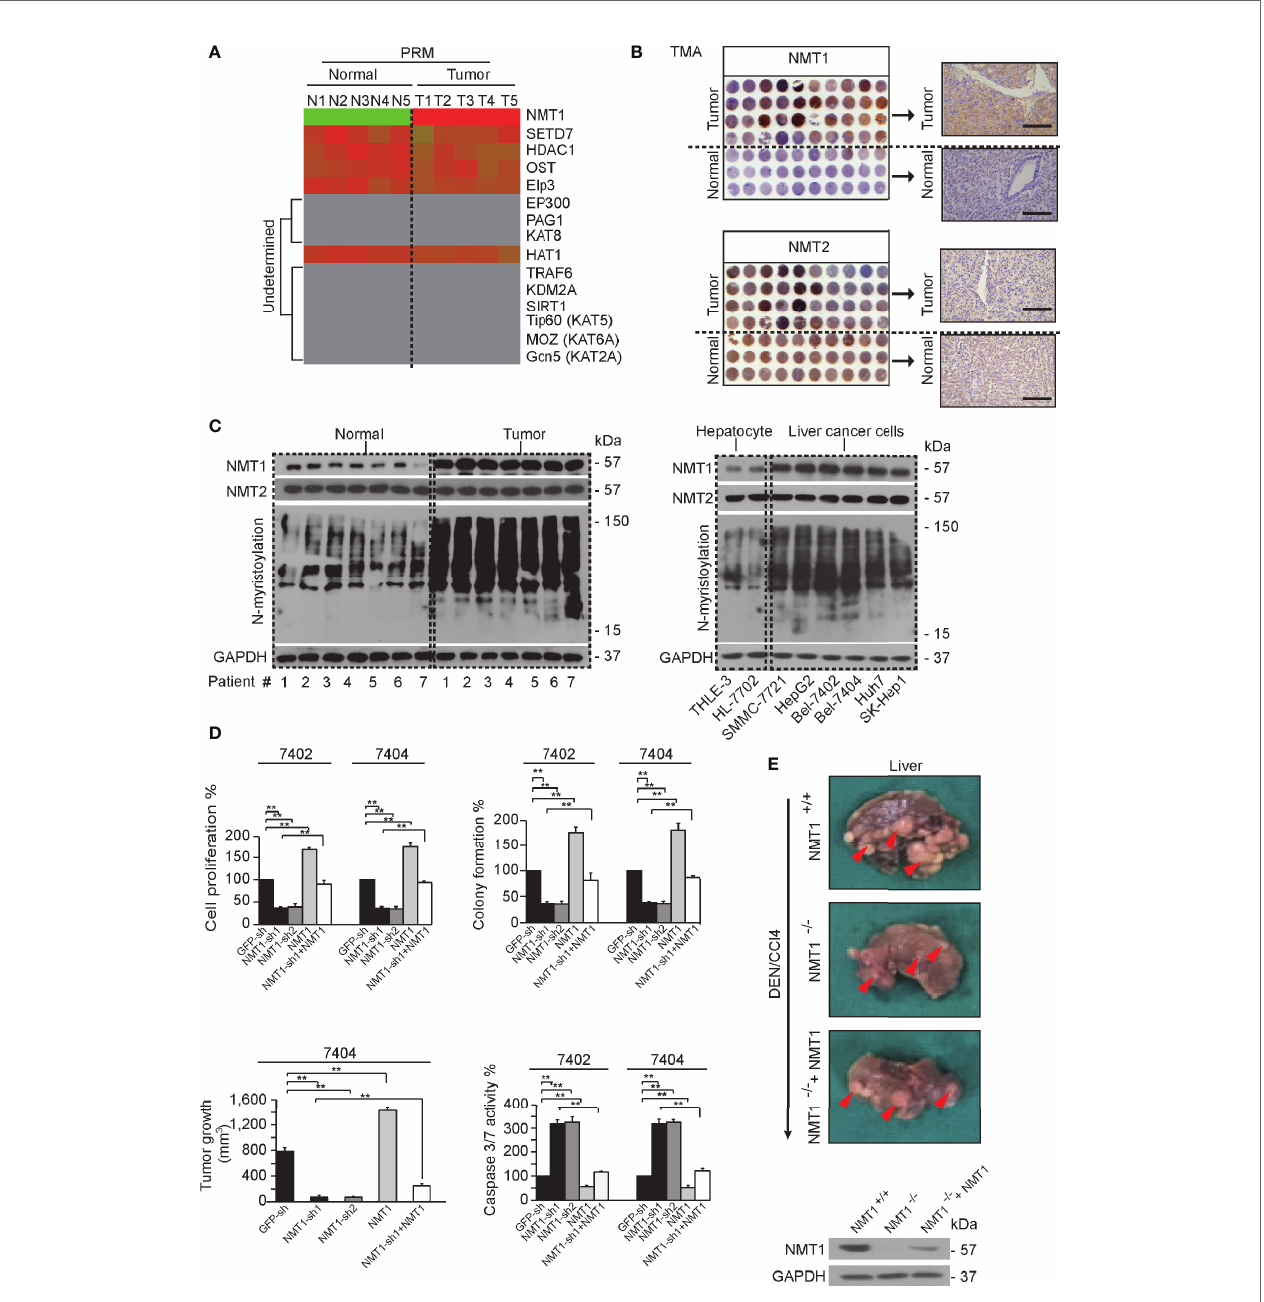
FIGURE 1 | NMT1 and N-myristoylation were critical for liver cancer (A) NMT1 was identi fi ed highly elevated in liver cancer. Five pairs tumor-normal liver specimen were subjected into the PRM experiment, and 15 protein modi fi cation enzymes including NMT1 were evaluated. (B) The expression of NMT1 and NMT2 was analyzed by TMA using IHC. The representative IHC images of tumor and normal liver tissues are shown on the right. Scale bar, 200 m m. (C) Representative WB images of NMT1, NMT2 and global N-myristoylation in tumor and normal liver tissues from 7 patients (left). The expression pattern of the same proteins is also shown in established hepatocyte and liver cancer cell lines (right). (D) NMT1 was critical for maintaining transformative phenotypes in liver cancer cell lines, Bel-7402 and Bel-7404. Capacities of cell proliferation, colony formation, and in vivo tumor growth as well as Caspase 3/7 activity were measured by an MTT-based proliferation assay, soft agar colony formation assay, xenograft assay and Caspase 3/7 Glo reagent, respectively, in control cells, Bel-7402 or Bel-7404 cells with NMT1 knocked down or overexpressed. (E) NMT1 was essential for DEN/CCl4-induced liver tumorigenesis. The liver from control mice (NMT1 +/+ ), NMT1 liver conditional knock-out mice (NMT1 − / − ) and NMT1 liver conditional knock-out mice injected with plasmids expressing exogenous NMT1 (NMT1 − / − +NMT1) are shown after DEN/CCl4 induction (upper). The representative tumor foci are indicated by red arrows. The protein levels of NMT1 were also measured by WB (lower), n=5/ group. The data are shown as the means + SD from 3 independent experiments ( Figure 1D except xenograft experiments). Images of WB are representative ones of 3 independent experiments. **p < 0.01 indicates statistical signi fi cance. The data from Figure 1D were analyzed by a one-way ANOVA